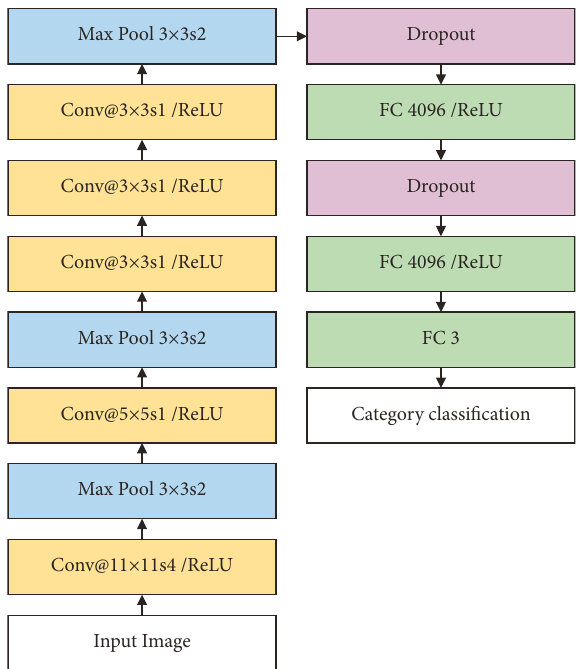
Figure 6: CNN structure constructed.